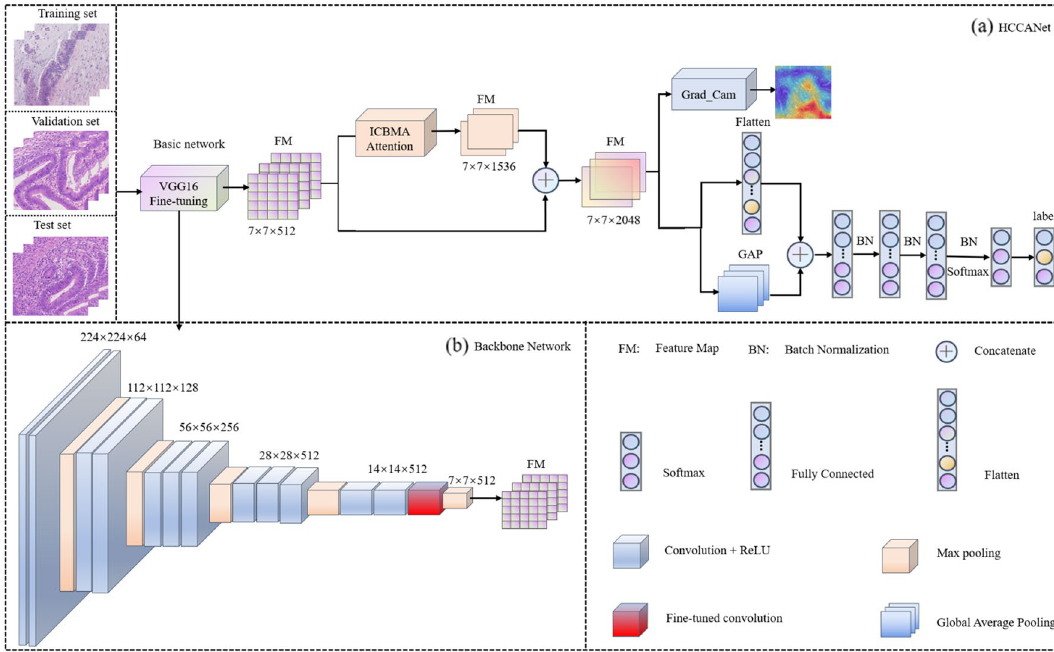
Figure 2. The framework of HCCANet. ( a ) The overall architecture of HCCANet. ( b ) The backbone of